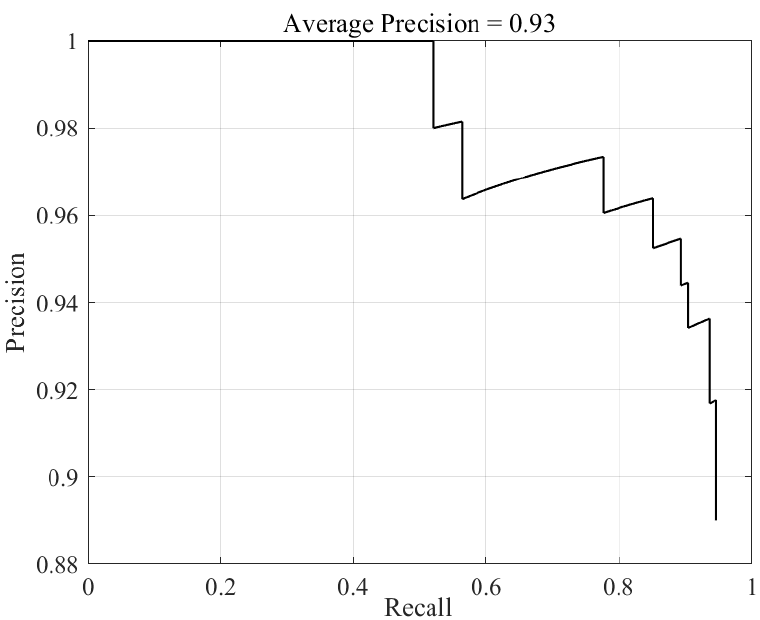
Figure 8. The precision/recall curve for a sunflower test sequence.